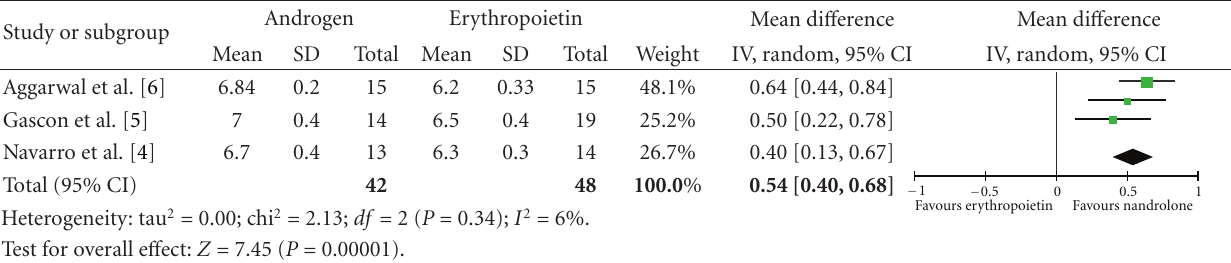
Table 3: Mean serum proteins at the end of the